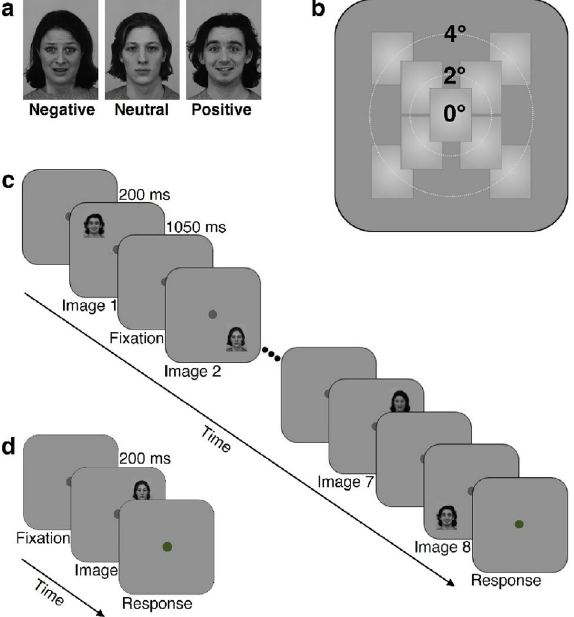
Figure 1. Experimental design. ( a ) Representative stimuli used in the experiments with negative (fearful), neutral, or positive (happy) valence (2° × 2.71°). All stimuli were from the Karolinska Directed Emotional Faces database 39 (in this figure de-identified image IDs are AF01AFS, AM18NES and AM35HAS). ( b ) 9 possible stimulus locations (central (0°) or parafoveally at 2° or 4° in one of 4 quadrants) appearing against a gray background (each condition was of one main valence appearing at only one eccentricity). ( c ) Block-design experiment: representative positive block at 2° (each block included 8 stimuli (5 with the dominant valence) appearing in pseudo-random order at the block’s eccentricity (2 photos/quadrant in the 2° and 4° blocks). Each block started with a fixation mark at screen center followed by 8 emotional images appearing for 200 ms each with ISI of 1050 ms. The participants were required to fixate and report the dominant valence across the block when the fixation turned green. ( d ) Single-trial experiment: representative neutral trial at 2° where participants initiated each trial (spacebar press) and while keeping fixation had to report the valence of a single stimulus (200 ms) when the green fixation appeared. See “Methods” section for more